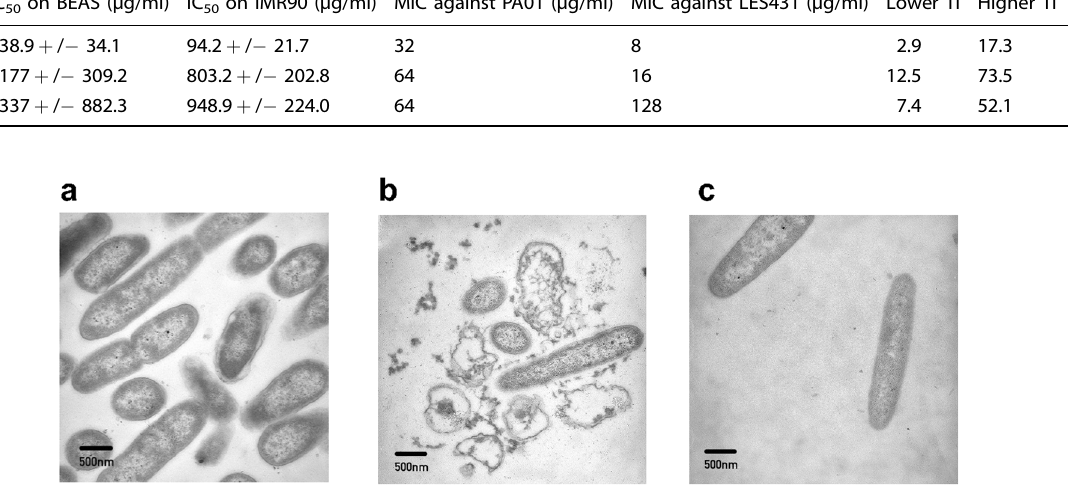
Fig. 3 Representative transmission electron micrographs of PAO1 cells. a Untreated PAO1 cells ( b ) Lynronne 1-treated (3× MIC for 1 h) PAO1 cells ( c ) P15s-treated (3× MIC for 1 h) PAO1 cells. 500 nm scale bars are shown on